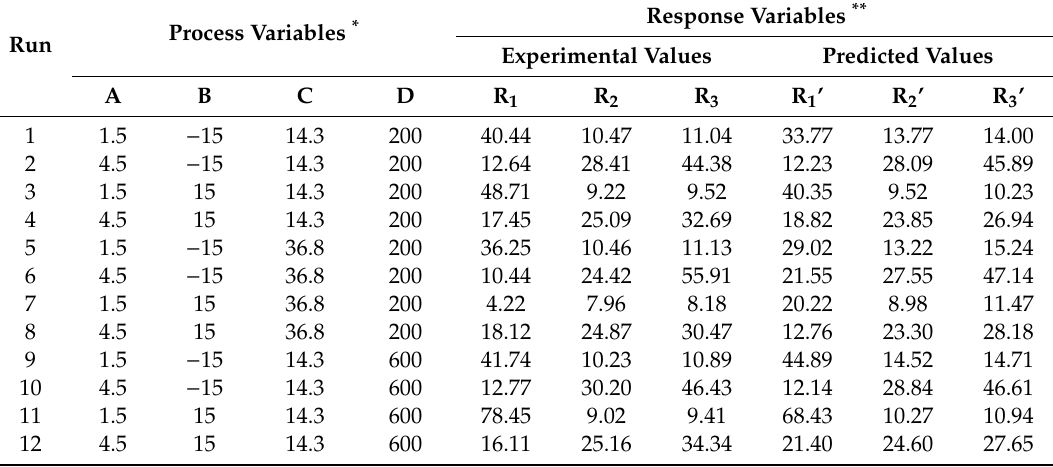
Table 2. Values obtained for the experimental and predicted response variables of RCSO concentrate by central composite rotatable design 2 4 + star based on the response surface methodology 1